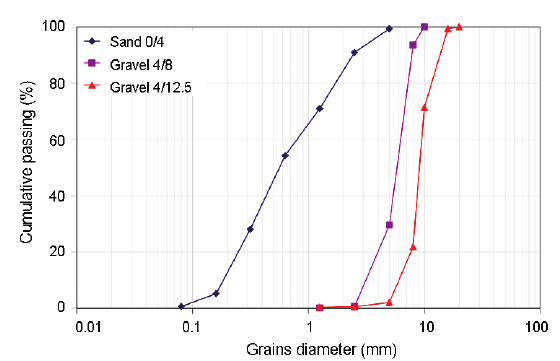
Fig. 2. Grain size distributions of coarse and fine